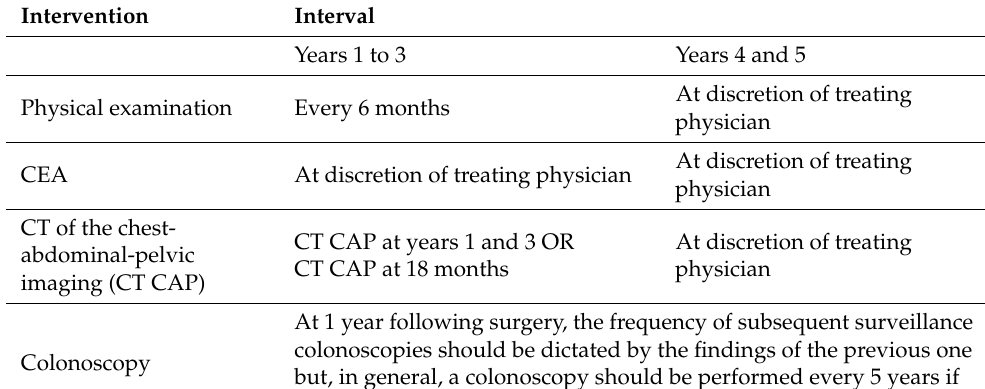
Table 1. Recommended evaluation and intervals for routine surveillance of stage I–III colon cancer